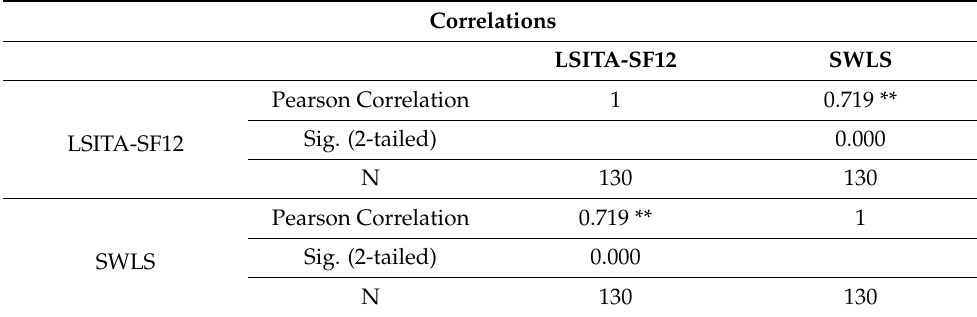
Table 2. The concurrent validity between 12 items Life Satisfaction Index for the Third Age—Short Form (LSITA-SF12) and the satisfaction with life scale